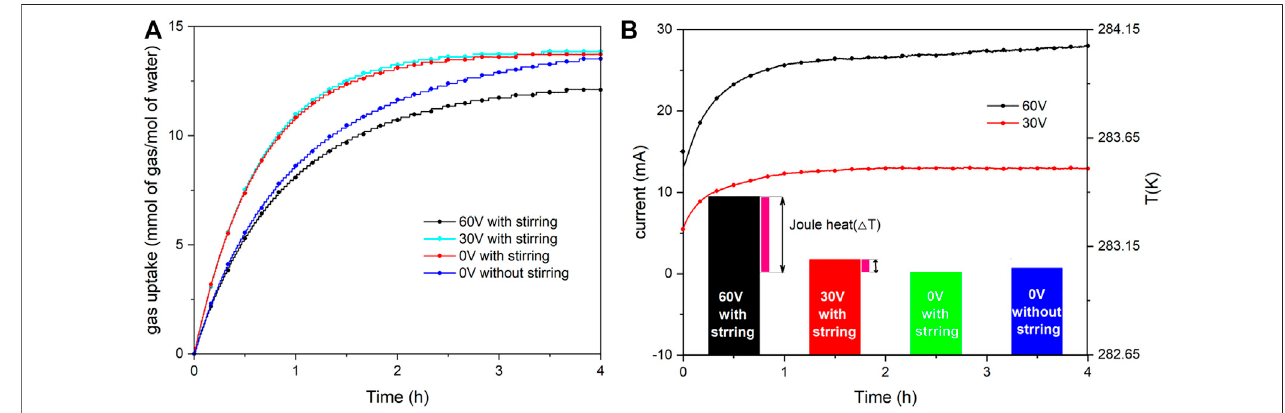
FIGURE 2 | (A) Gas uptake during the CO 2 dissolution process in different conditions at 3.5 MPa and 283.15K; (B) The current of solution pro fi les and the fi nal temperature of liquid phase.